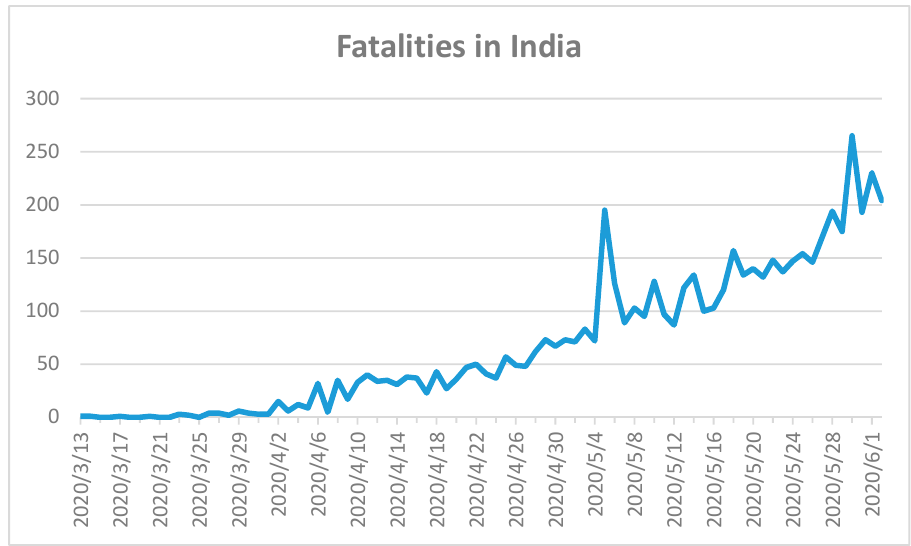
Figure 10. Confirmed COVID-19 fatalities in India until 2 June 2020 [18]. First fatality on 13 March 2020 in India.